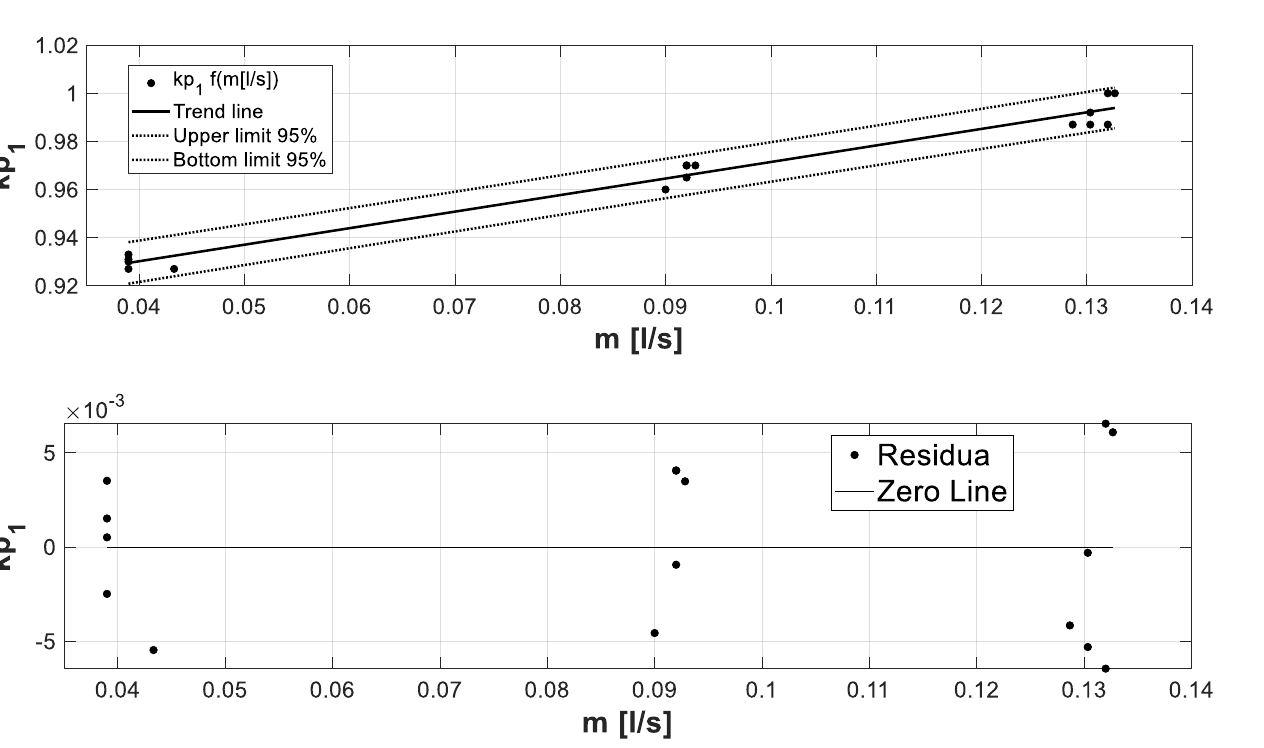
Figure 12. Impact of the circulator pump output on the value of the thermal conductivity coefficient. Analyzing the distribution of deviations for individual values of the heat transfer coefficient, it can be observed that the highest error of 2.17% occurred for a flow rate of 0.137 [l/s]. This demonstrates the repeatability of the results. Figure 13 shows the impact of the circulator pump output on the value of the equivalent time constant of the heat exchanger. The graph shows that the higher the output of the circulator pump, the lower